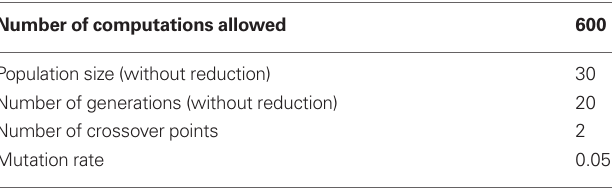
Table 3 | The frequency of the correct model being selected over 200 trials. The first 4 schemes are with the modifications and the last is